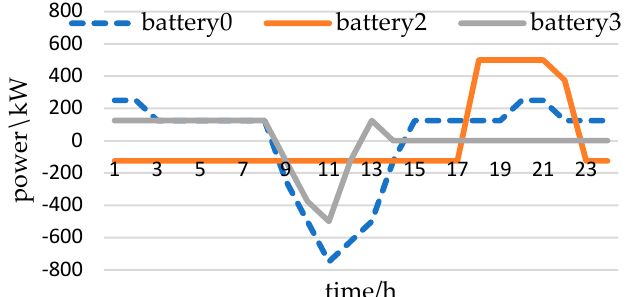
Figure 8. Power output of the three planned ESSs.